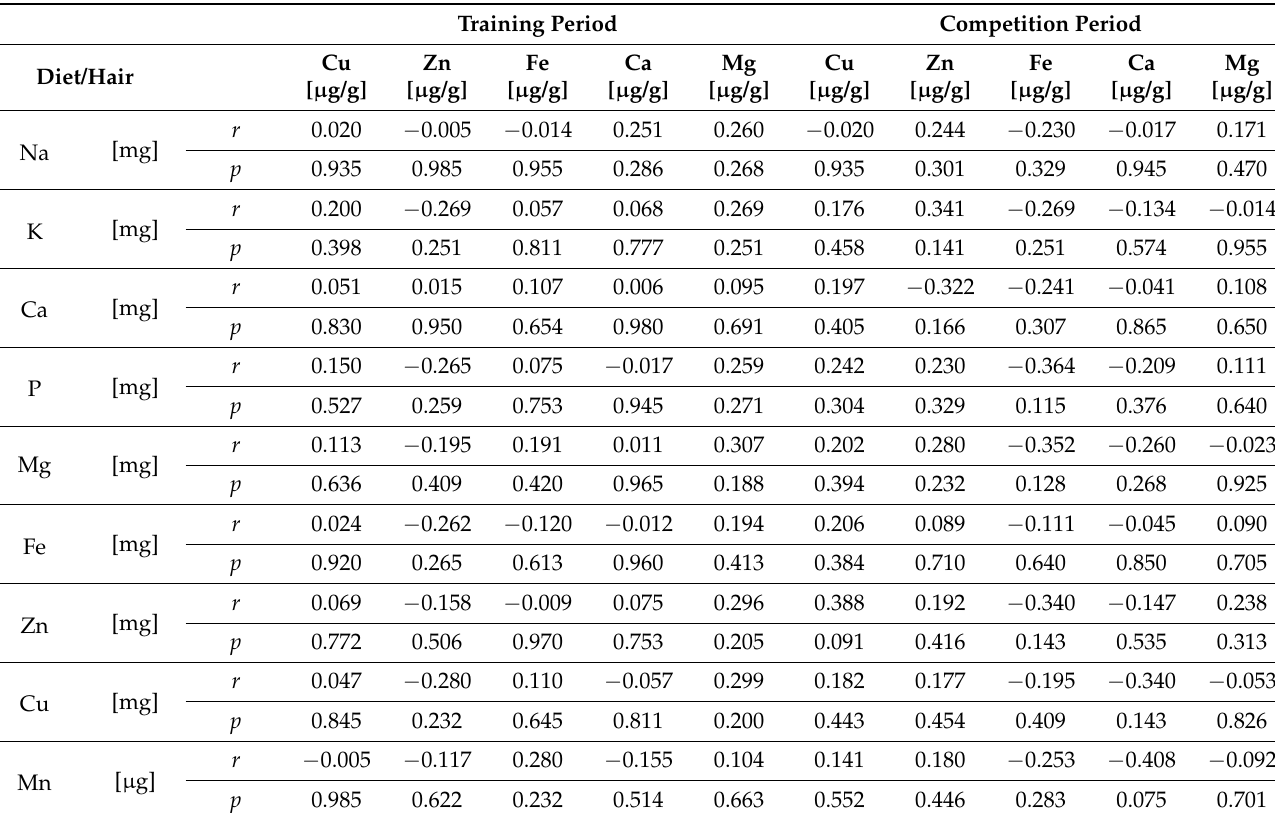
Table 7. Spearman correlation coefficient between hair mineral content and the intake of minerals in the usual diet of